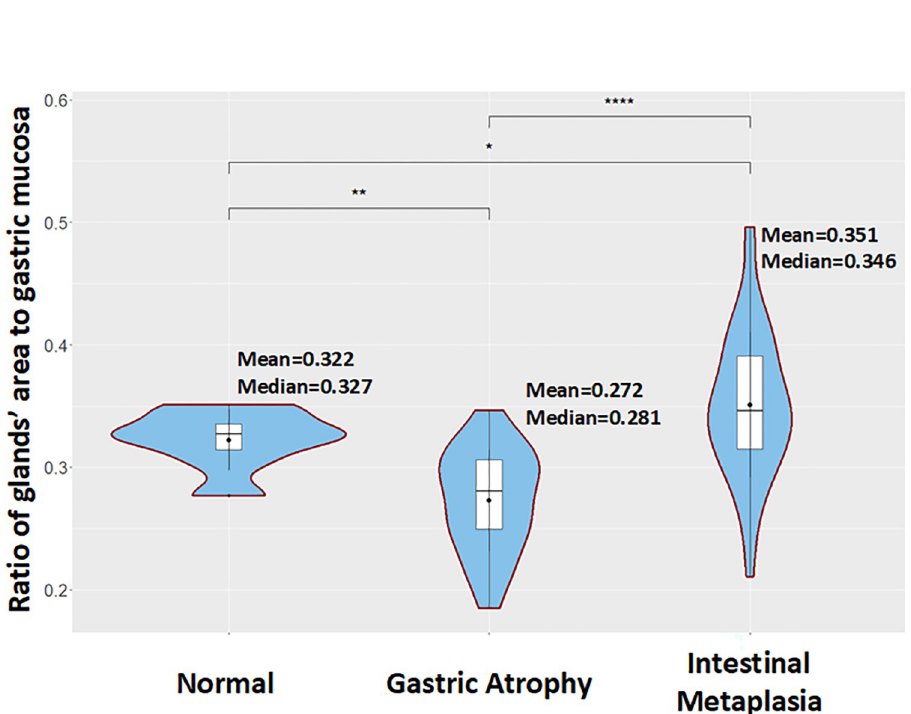
Fig 10. Box plots comparing the ratio of the area covered by glands to gastric mucosa between normal, Gastric Atrophy (GA) and Intestinal Metaplasia (IM) cases included in the GAGL dataset.